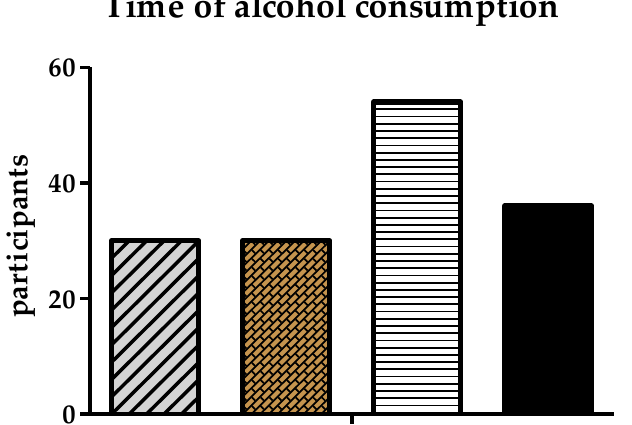
Figure 7. Frequency of alcohol consumption by the participants.